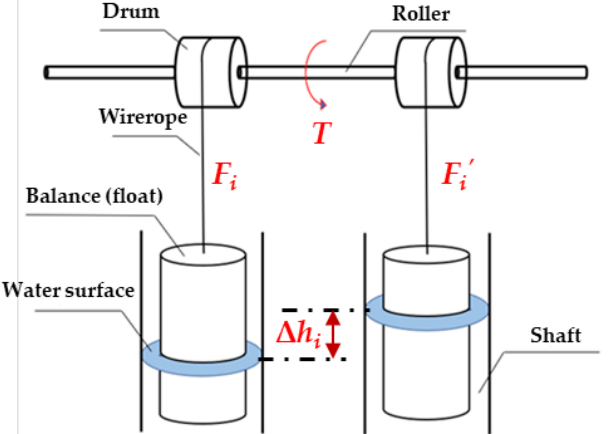
Figure 3. Water surface deviation from the shafts causes torque to be generated by the roller among drums.